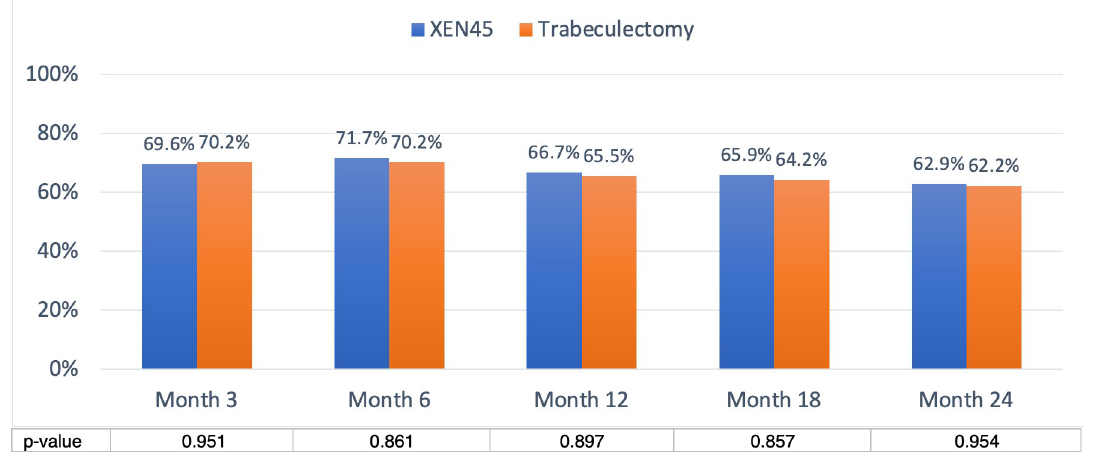
Fig 5. Complete success was defined as postoperative IOP reduced � 20% from the preoperative baseline, without any medications. Complete success of XEN implant and trabeculectomy were comparable at all timepoints. At month 24, the complete success rates were 62.9% versus 62.2%